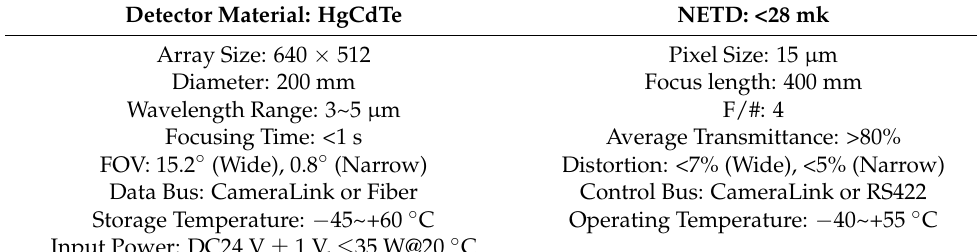
Table 3. Specifications of the MWIR sensor.